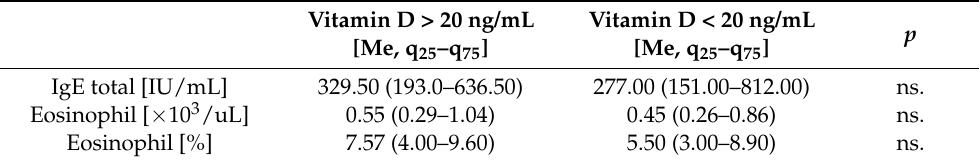
Table 2. Effect of vitamin D on the concentration of IgE total and eosinophils.